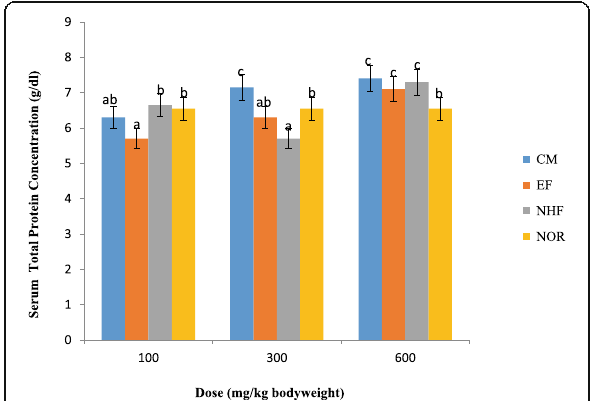
Fig. 5 Effect of crude extract and fractions of Gymnema sylvestre on serum total proteins concentrations of rats. Mean with different superscripts differ significantly (p < 0.05). Key: NOR: normal control,